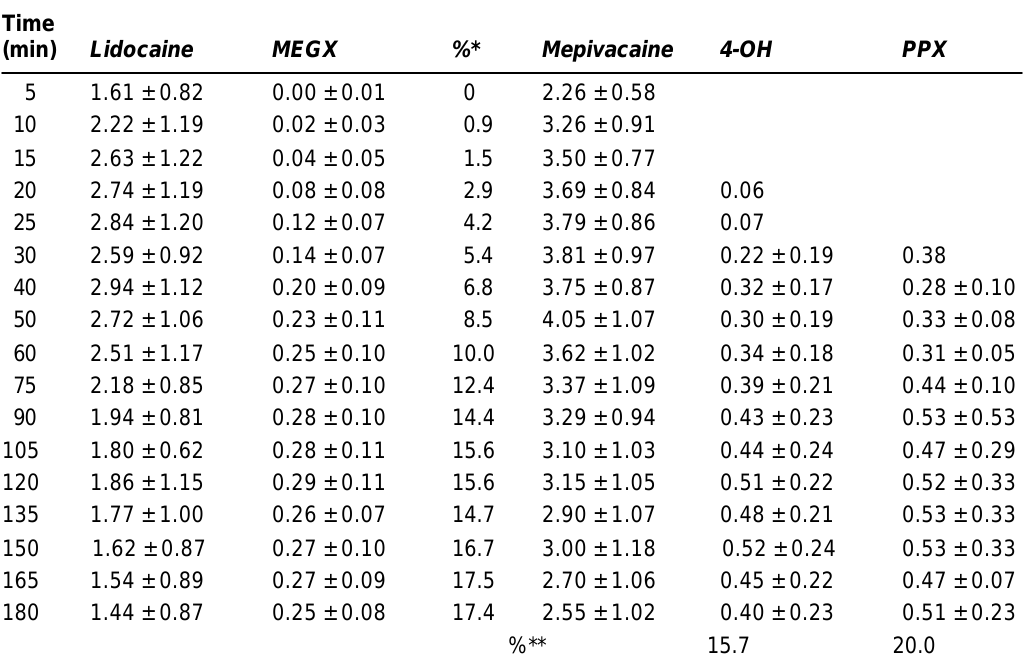
Mean Plasma Concentrations (mg l –1 ± s.d.) of Mepivacaine with Metabolite 4-OH and PPX and Lidocaine with its Metabolite MEGX after Axillary